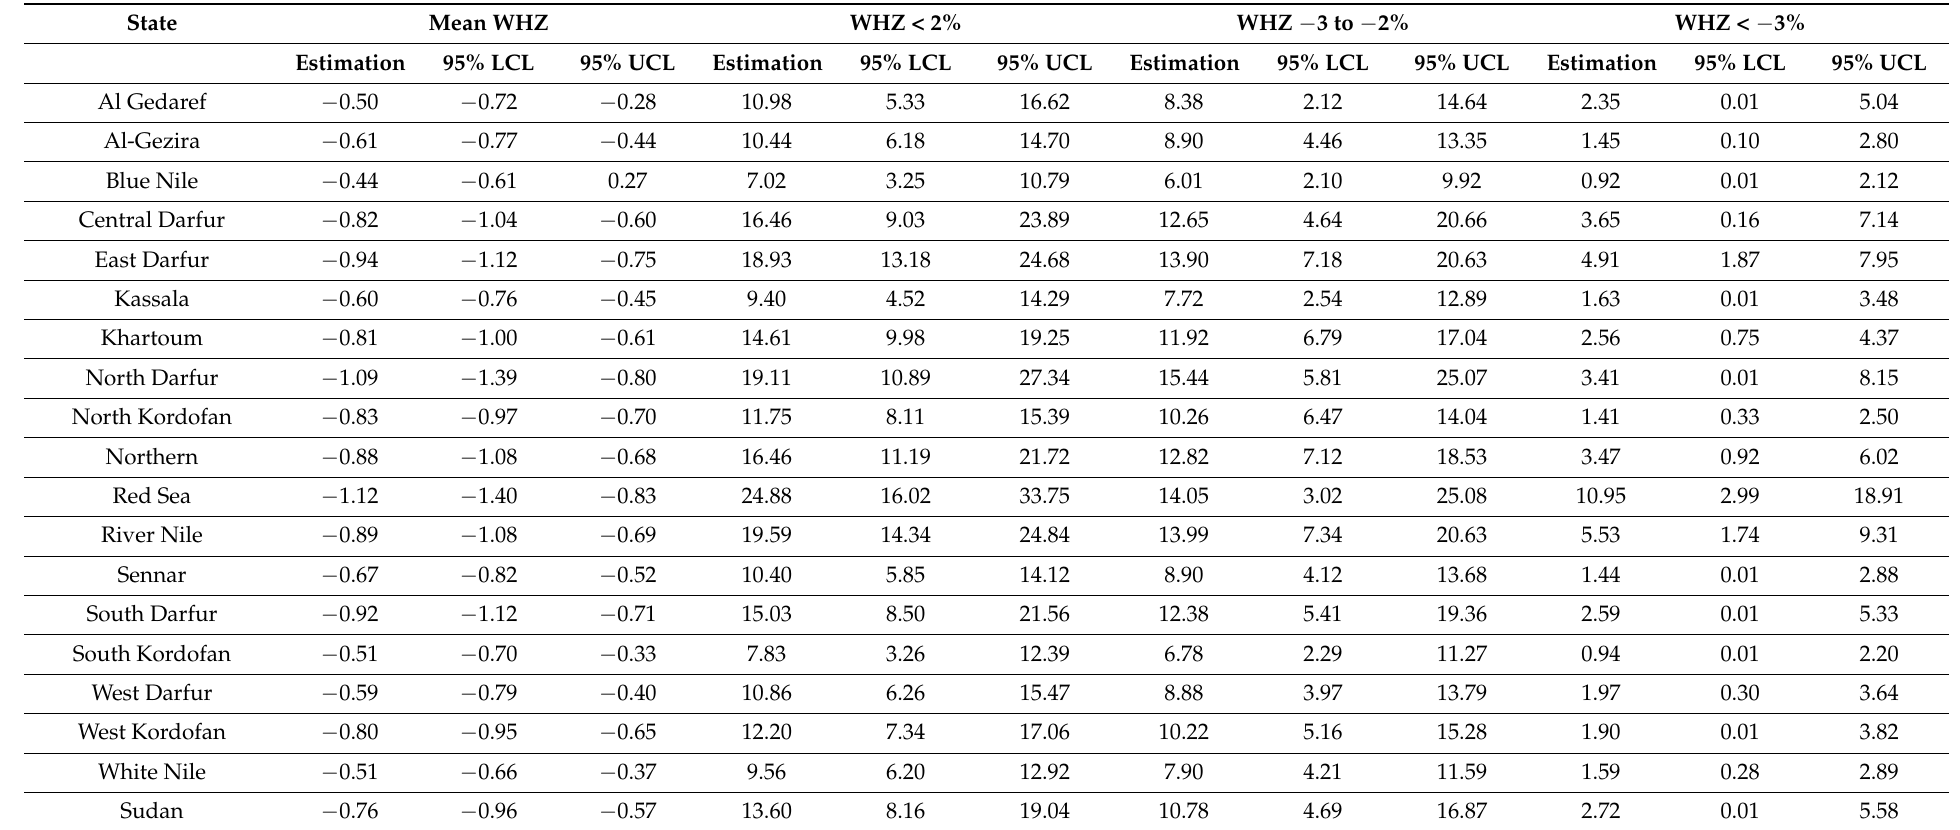
Table 4. Distribution of wasting prevalence and mean by